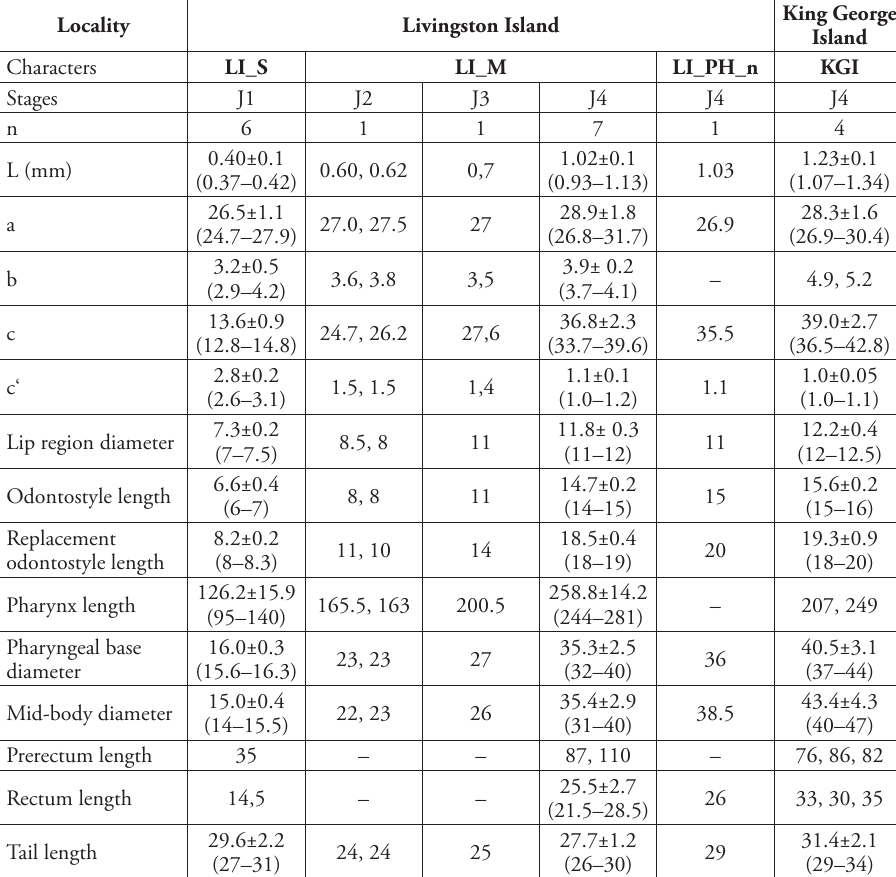
Table 3. Morphometrics of Enchodeloides signyensis gen. n., comb. n. (juveniles). All measurements, un- less indicated otherwise, are in µm (and in the form: mean±SD